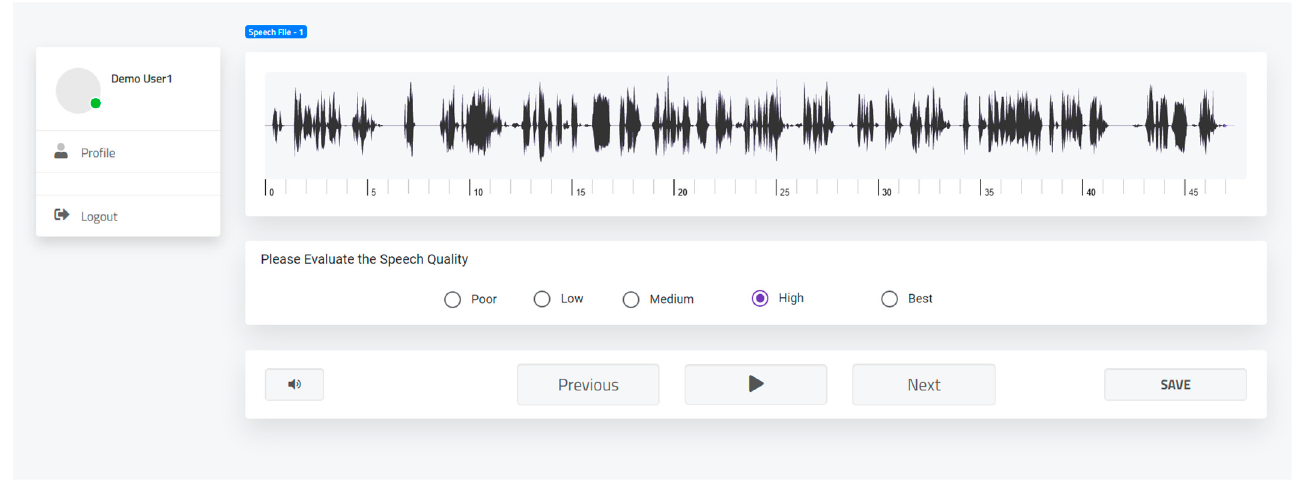
Figure 6. MOS evaluation interface.